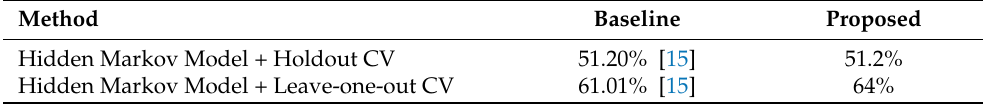
Table 7. The comparison of the proposed method with existing state-of-the-art technique.